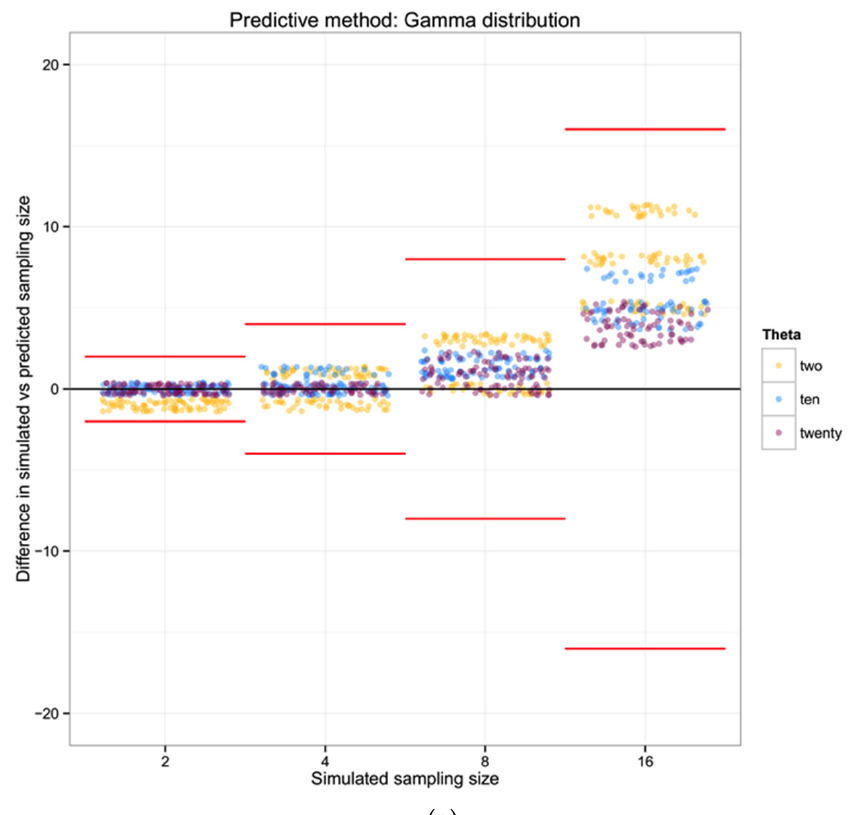
Figure 3. Cont. Figure 3.